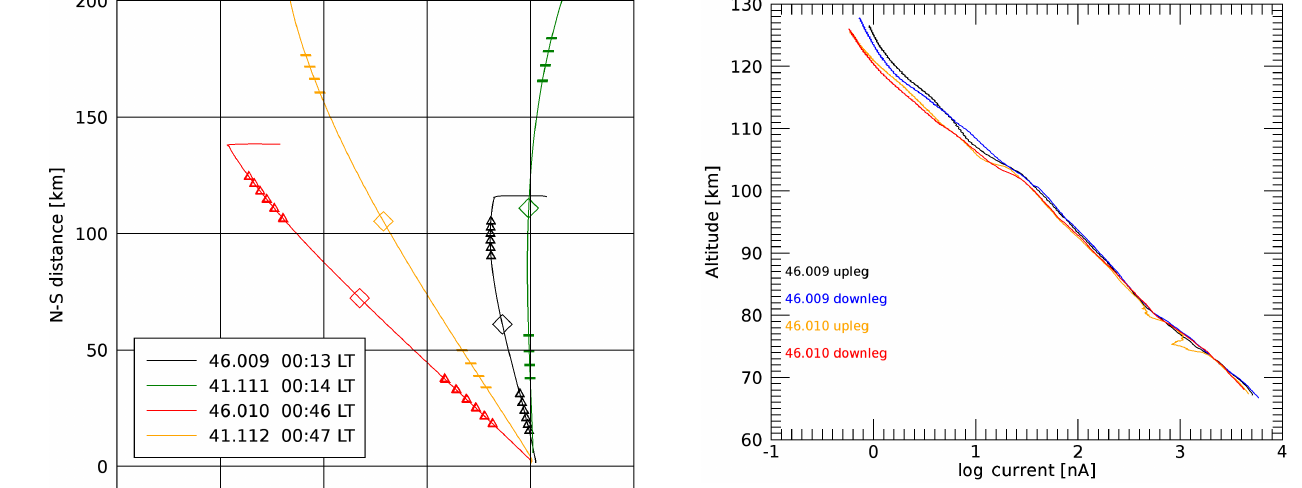
Figure 2. Four profiles of ion currents observed during the MTeX flights. Each pair of upleg and downleg profiles was obtained with a single CONE